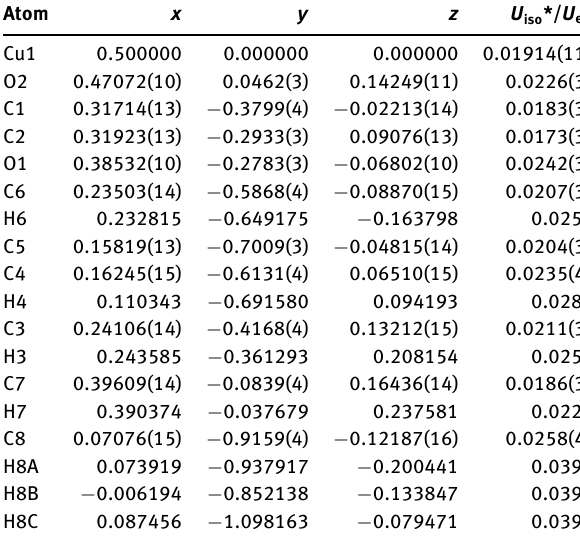
Table 2: Fractional atomic coordinates and isotropic or equivalent isotropic displacement parameters (Å 2